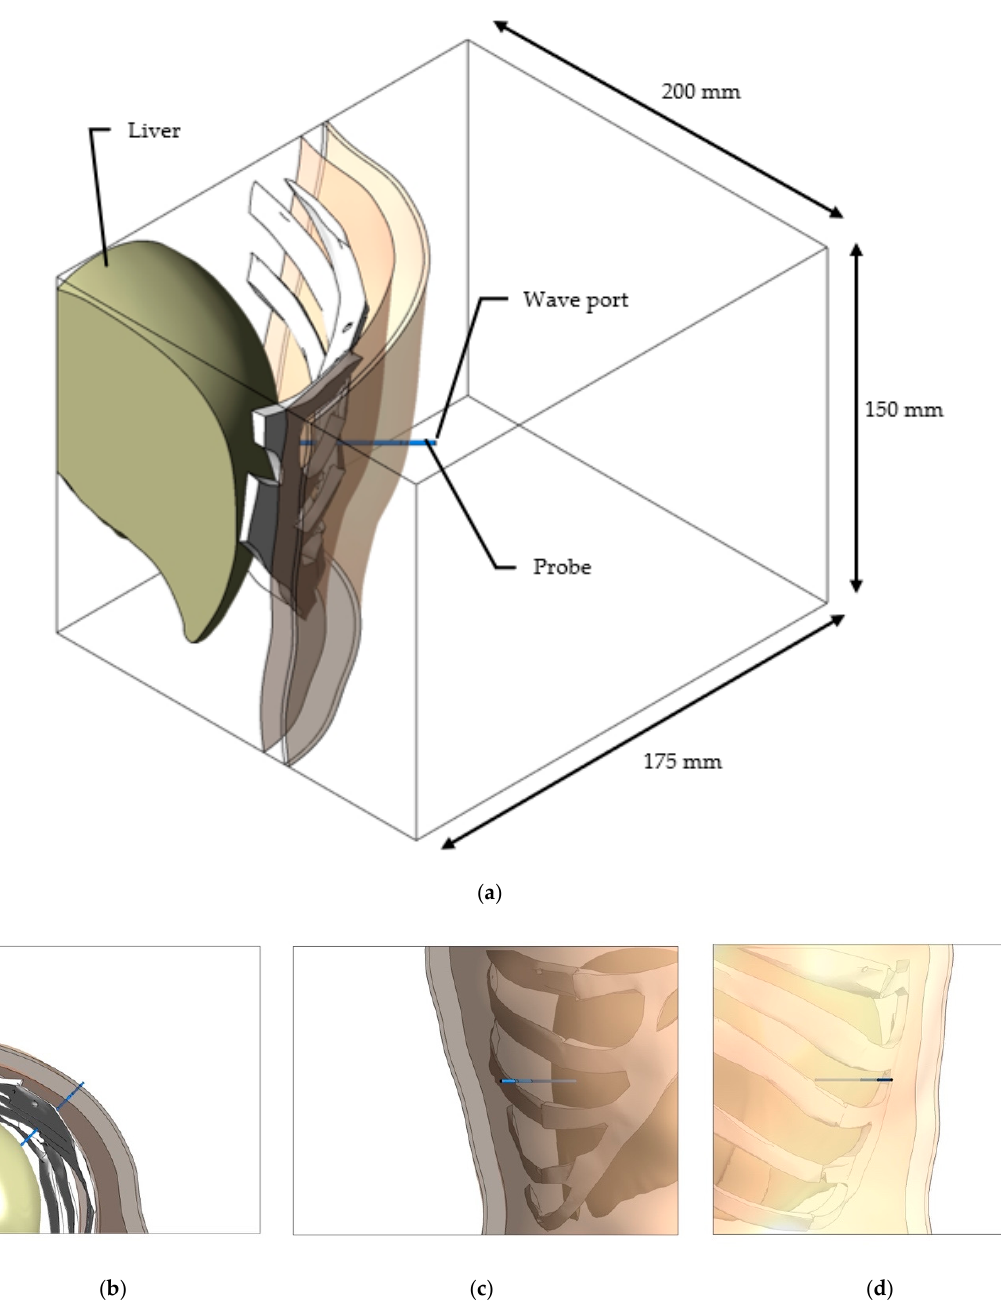
Figure 2. Schematic diagrams of the microwave probe within the human model. ( a ) Isometric view, ( b ) Top view, ( c ) Front view, and ( d ) Side view.